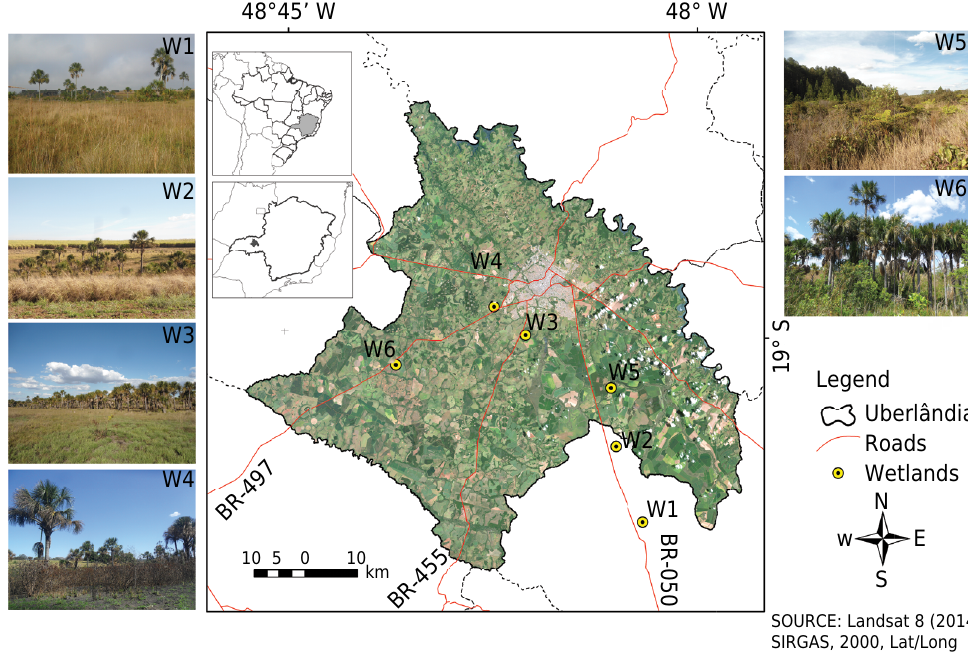
Figure 1. Location and overview of selected wetlands (W1, W2, W3, W4, W5, and W6), Uberlândia region, Minas Gerais State, Brazil. The palm Mauritis flexuosa L.f. can be seen in W1, W2, W3, W4, and W6 wetland